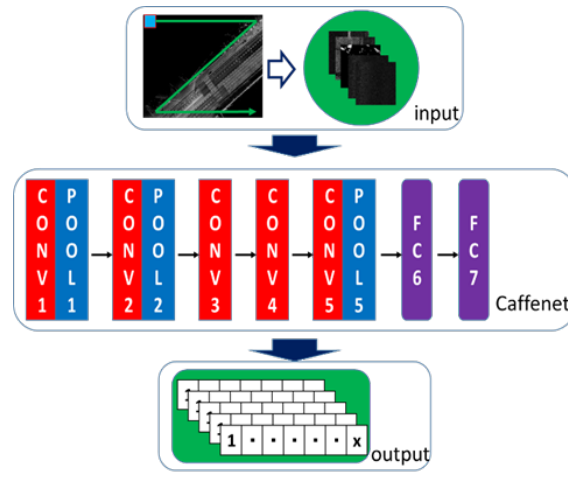
Figure 2. The overview of feature extraction by CNN.